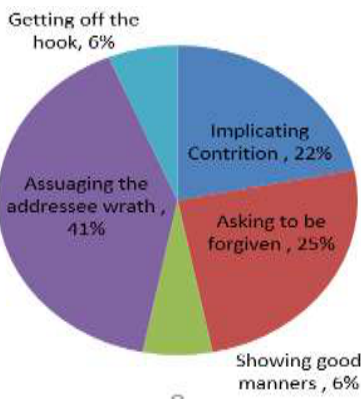
Figure 3: Social Functions of